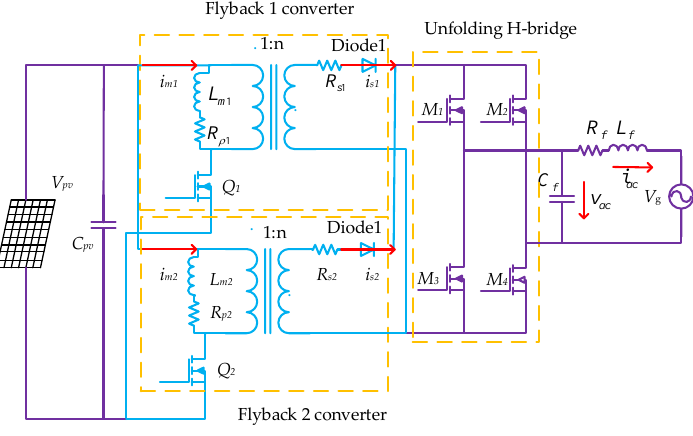
Figure 1. The interleaved flyback mirco-inverter topology.